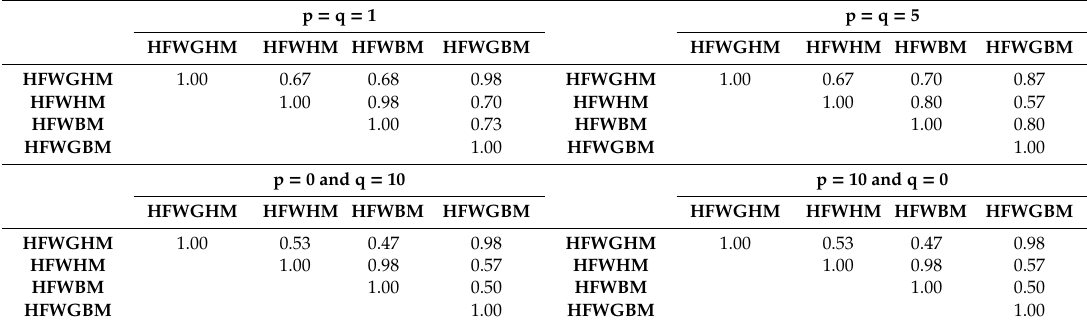
Table 13. The correlation coefficients of the ranking resulted from different hesitant fuzzy operators.